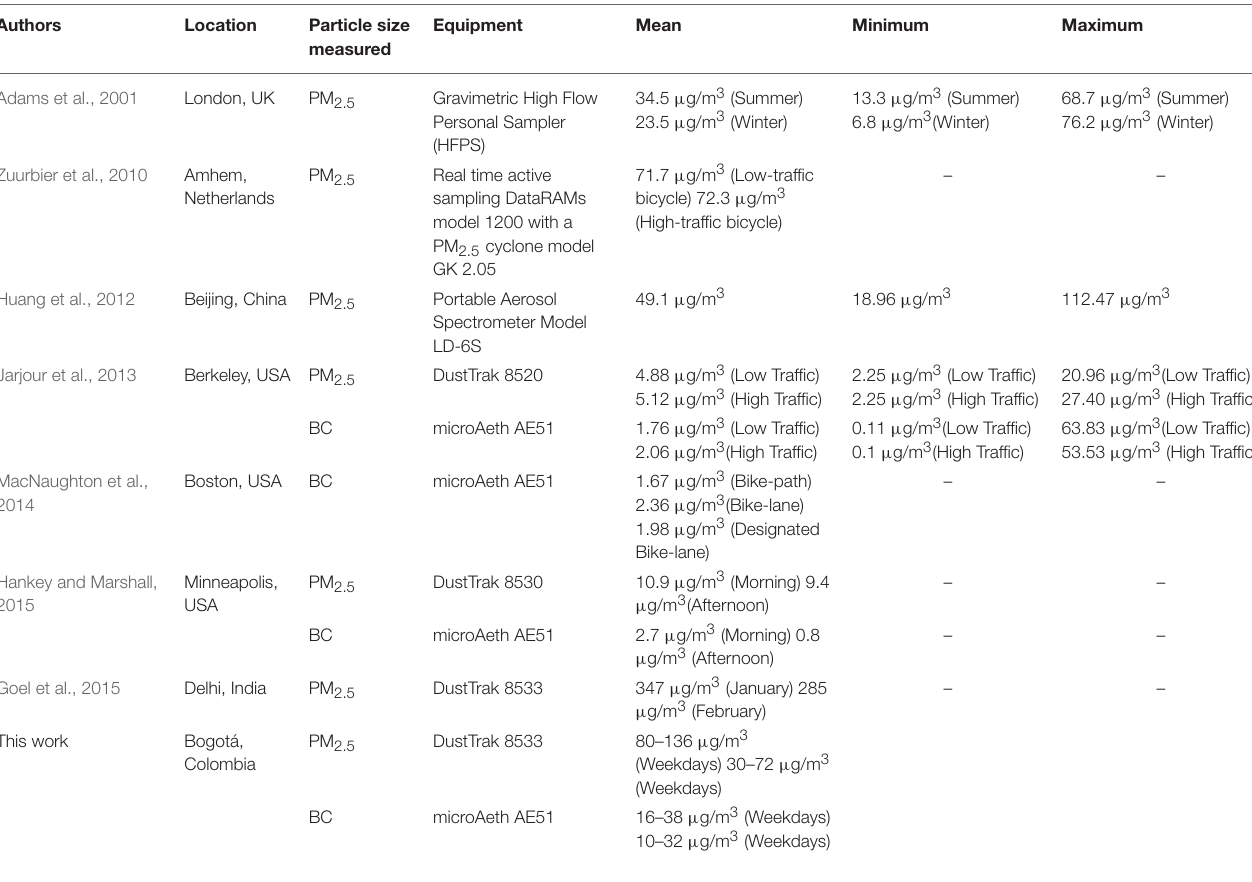
TABLE 4 | International studies assessing the exposure levels of bike-path users.